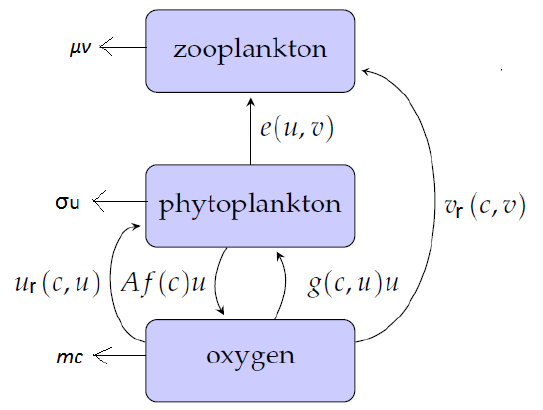
Figure 1. The structure of the conceptual model describing the interactions between oxygen ( c ), phytoplankton ( u ) and zooplankton ( v ). Arrows show the flows of matter through the system, and the parameterizations of the rates are as labelled. Phytoplankton produces oxygen through photosynthesis during the day-time then consumes it during the night [13]. Zooplankton feeds on phytoplankton and consumes oxygen through breathing; see further details in the text.